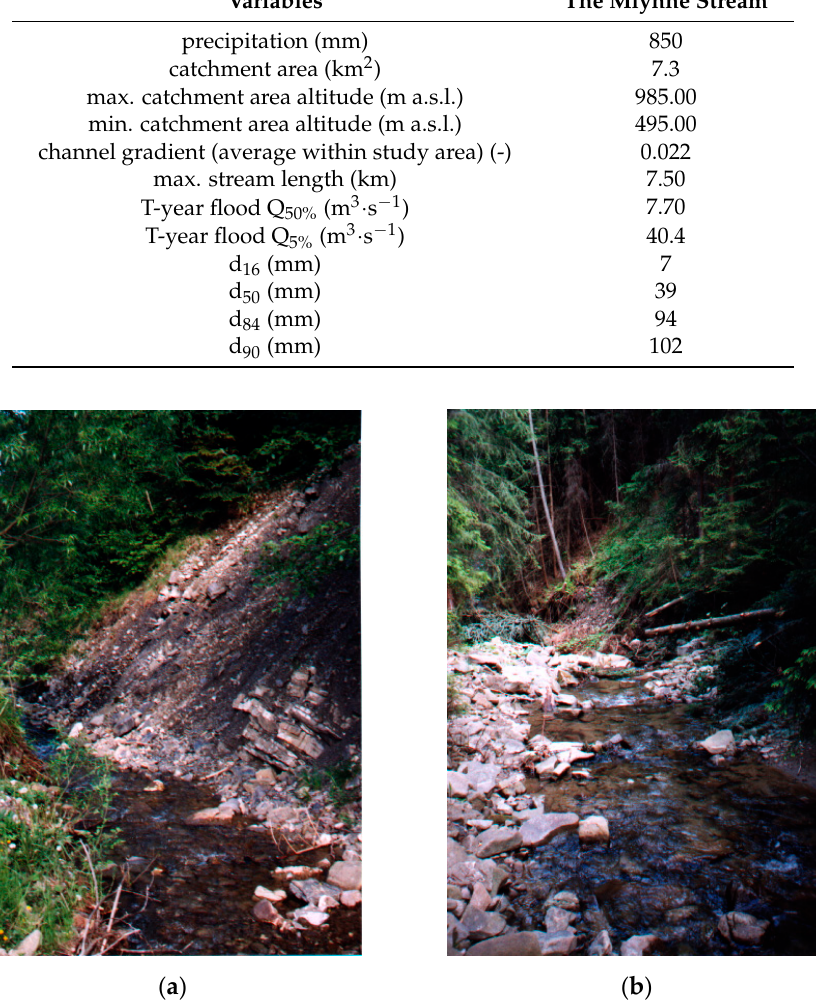
Figure 2. Mlynne stream—natural cross sections. ( a ) upper part not engineered; ( b ) source part.